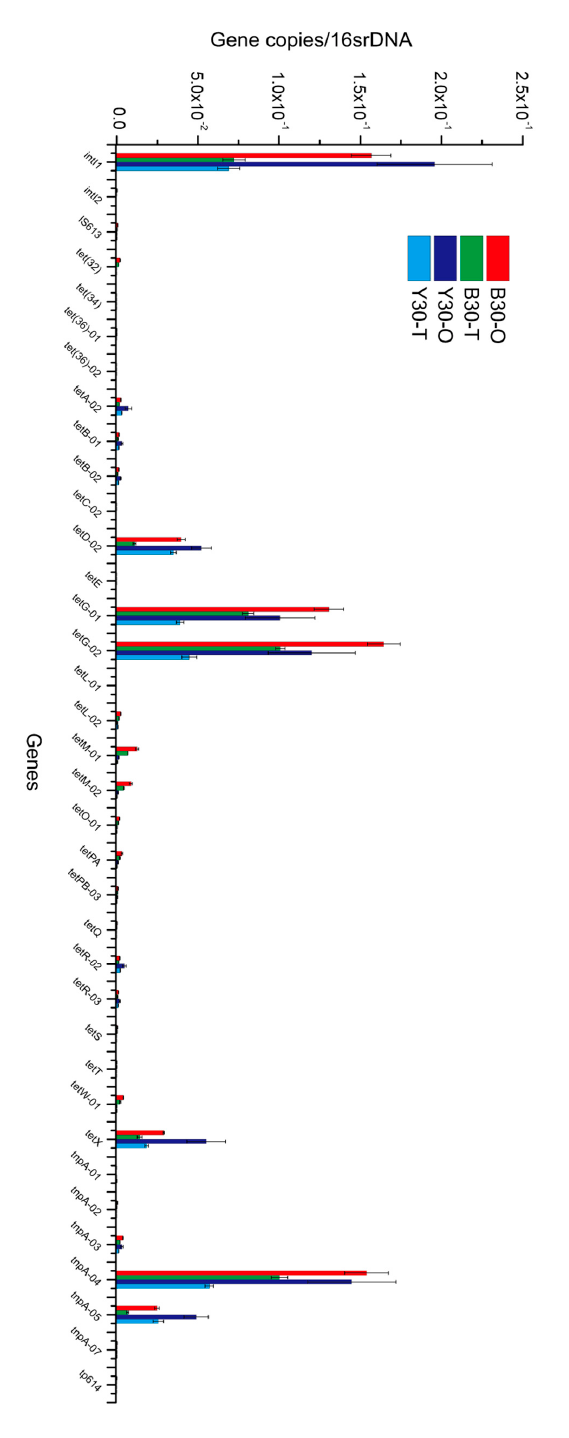
Figure 4. Relative abundance of tetracycline resistance genes (TRGs) and mobile gene elements (MGEs) before and after the microbial remediation. B30-O and Y30-O stand for original soil samples, whiles B30-T and Y30-T stand for soil samples collected on day 65.